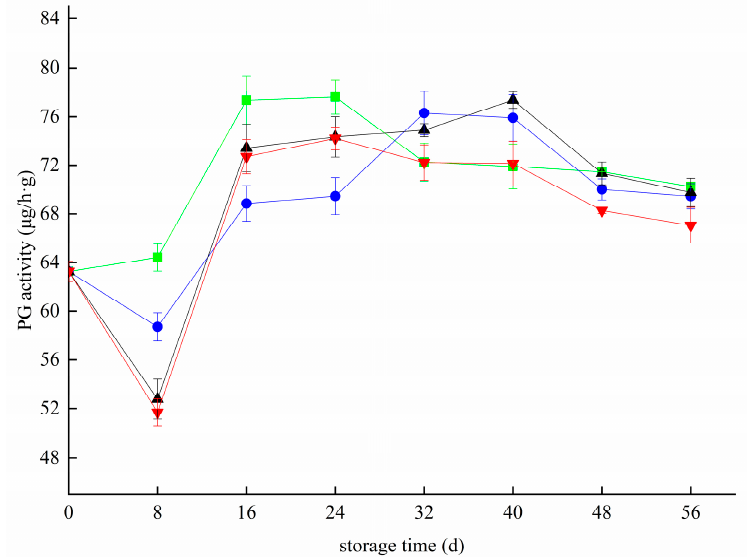
Figure 4. Effect of polygalacturonase activity in blueberry under different treatments. ■ : control; ● : T; ▲ : Z: ▼ : T plus Z.